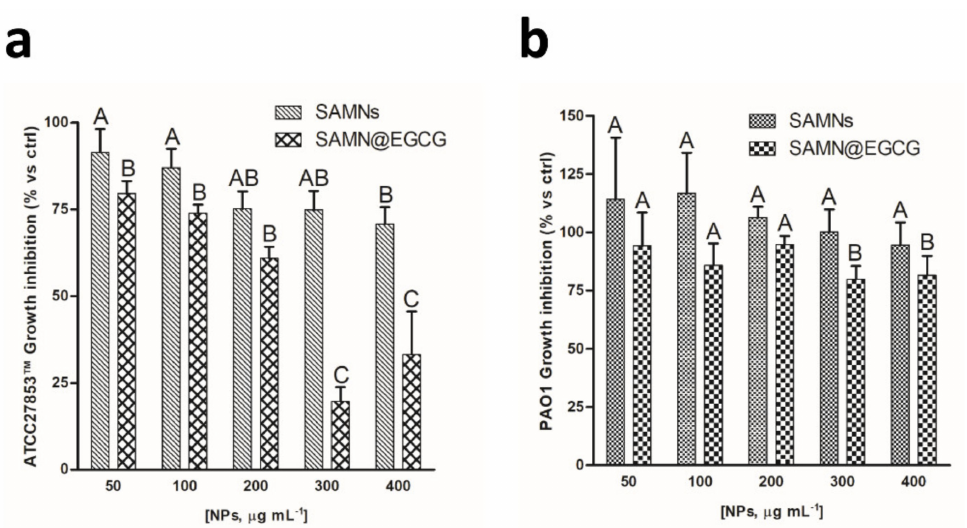
Figure 7. Inhibitory effect of SAMN@EGCG nanohybrid on P . aeruginosa growth. Different con- centrations of SAMN@EGCG nanohybrid and bare nanoparticles were assayed on P . aeruginosa ( a ) ATCC27853™ and ( b ) PAO1 strains. The effect of each concentration on bacterial growth is expressed as percentages with respect to the control. Different lower-case letters represent significant ( p < 0.01) differences between treatments according to pairwise comparison among